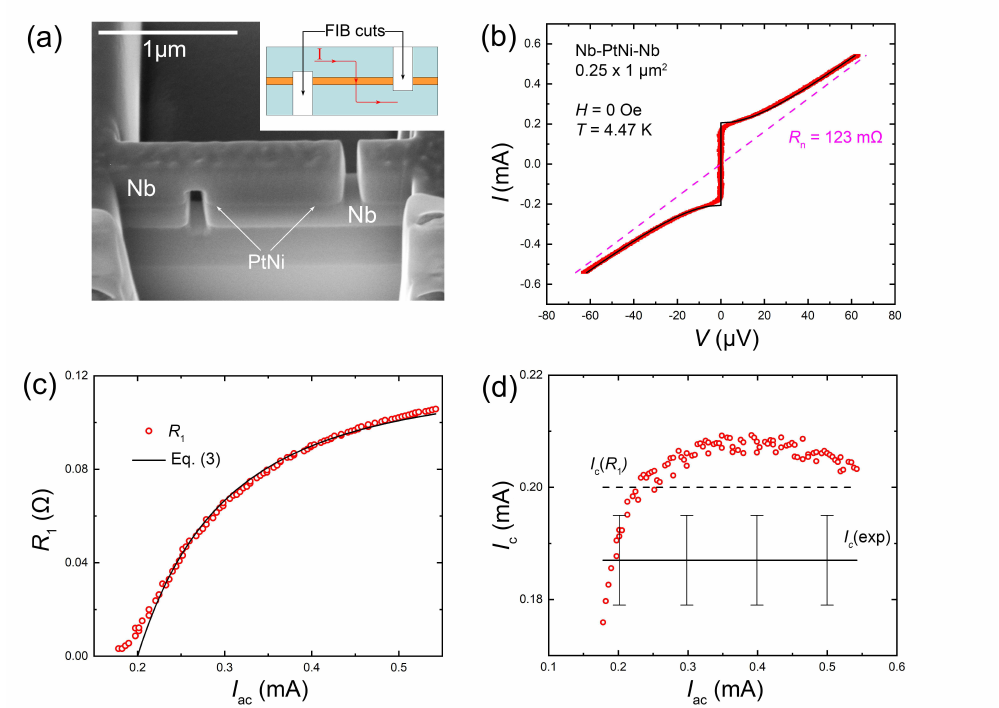
Figure 1. ( a ) An SEM image and a sketch of a Nb–PtNi–Nb junction. ( b ) Experimental current–voltage characteristics of the junction at H = 0 and T = 4.47 K (red symbols). The black line represents the RSJ fit, Equation (1). ( c ) Red circles show the dependence of the first harmonic lock-in resistance on the ac-current amplitude for H = 0 and T = 4.47 K. The black line shows the fit by Equation (3), using I c as a fitting parameter. ( d ) Red circles represent I c vs. I ac reconstructed from the data in ( c ), using Equation (6), with R n as a fitting parameter. The solid horizontal line represents I c ( exp ) obtained from the I – V in ( b ) with error bars due to smearing at I (cid:39) I c . The dashed line represents I c ( R 1 ) obtained from the fitting by Equation (3) in ( c ). A small systematic overestimation of the reconstructed I c was caused by smearing of the experimental I – V by fluctuations and